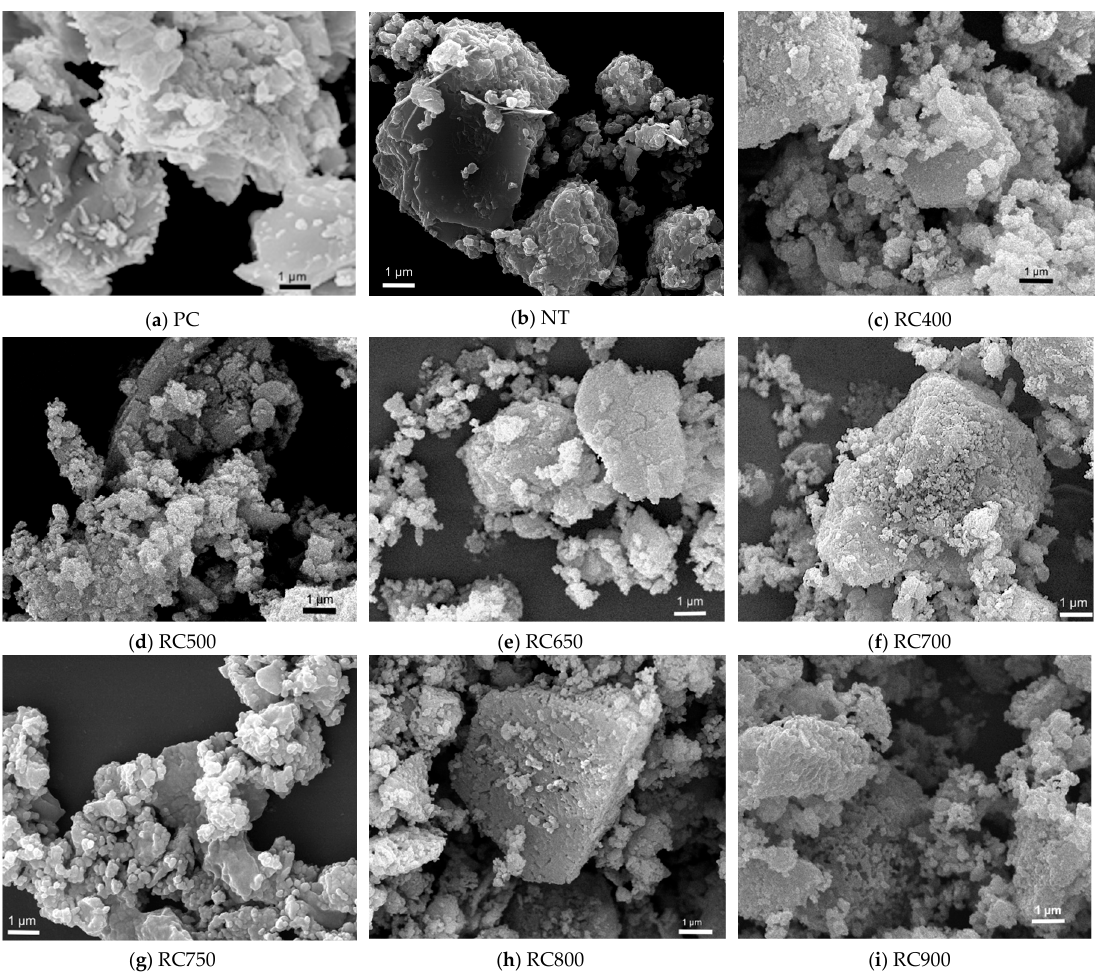
Figure 1. Cement particulates. FEG-SEM images of ( a ) PC, ( b ) NT waste cement, and RC treated at: ( c ) 400, ( d ) 500, ( e ) 650, ( f ) 700, ( g ) 750, ( h ) 800 and ( i ) 900 °C.